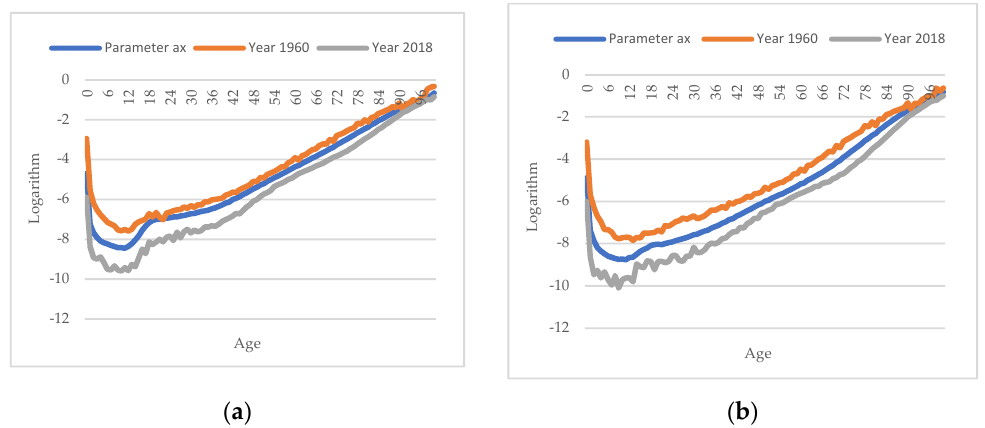
Figure 1. ( a ) Values of the a x parameter according to the age for the Spanish male population and gross values of the mortality rates of the extreme calendar years; ( b ) values of the a x parameter according to the age of the Spanish female population and gross values of the mortality rates of the extreme calendar years. Source: authors.